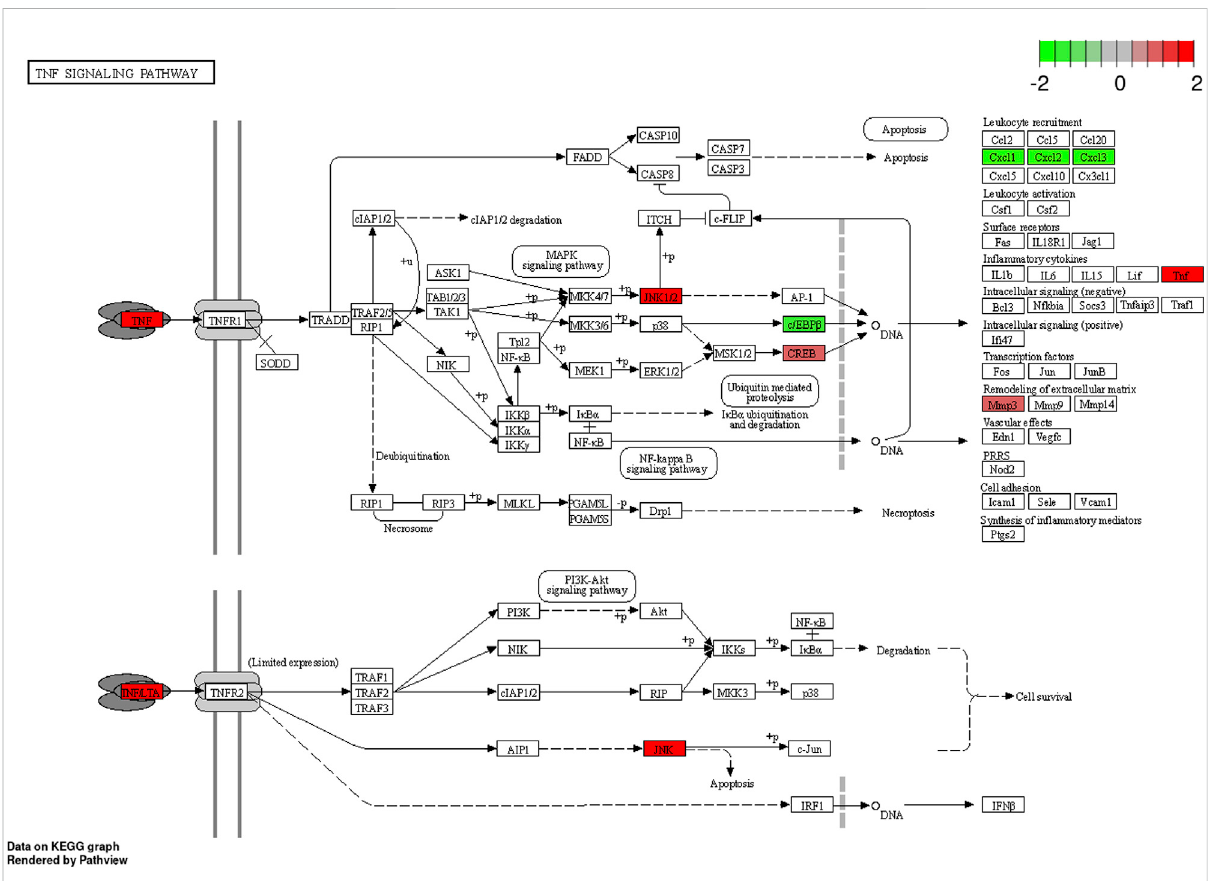
FIGURE 6 Differentially expressed genes enriched in the path diagram of the TNF signaling pathway.